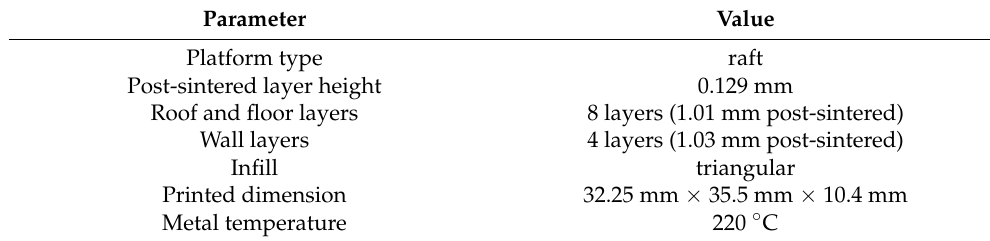
Table 2. Main printing parameters in Metal X